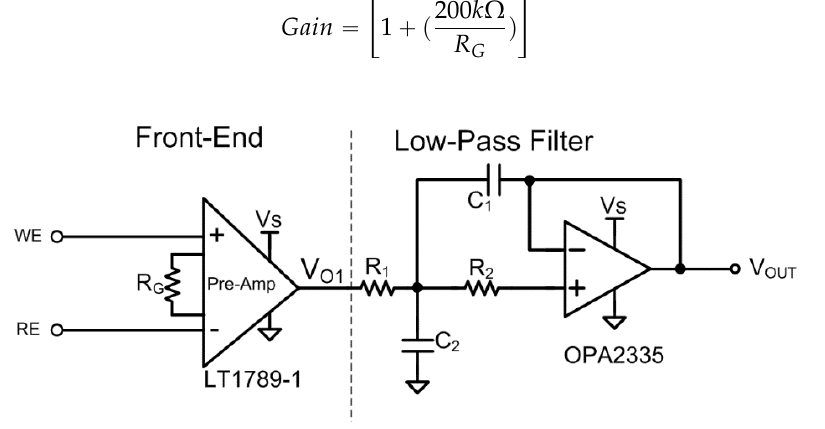
Figure 4. The proposed bio-electrochemical readout circuit for OCP measurement.